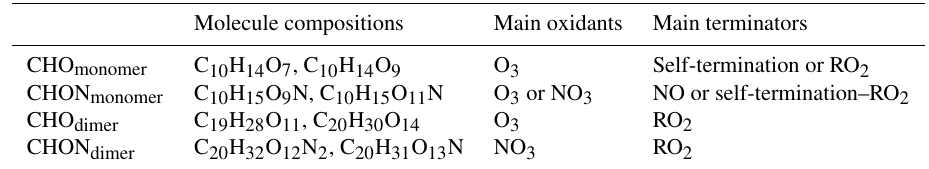
Table 2. Compositions of selected HOMs and their main oxidants (Yan et al., 2016).